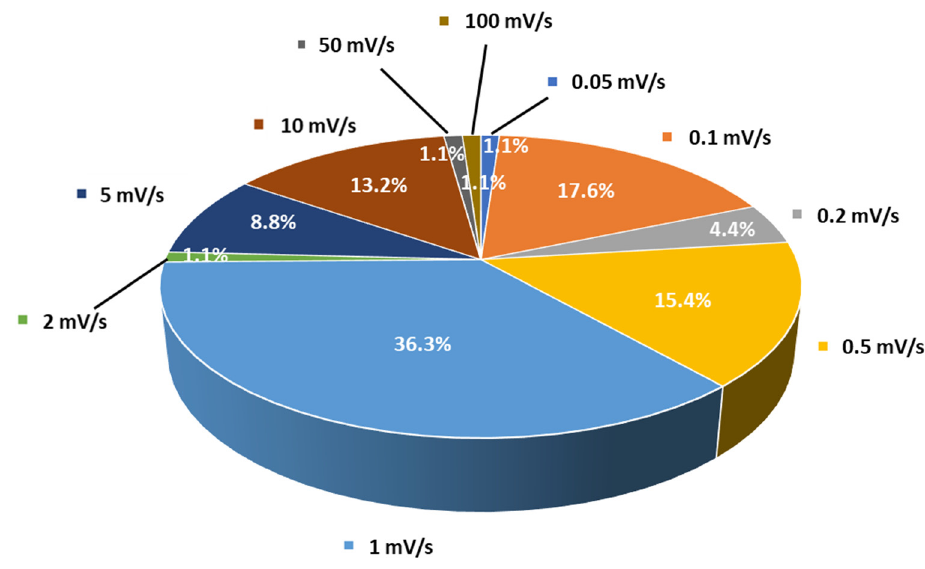
Figure 6. Distribution of scanning rates (%) used by authors for ESW evaluations taken from Table 1.